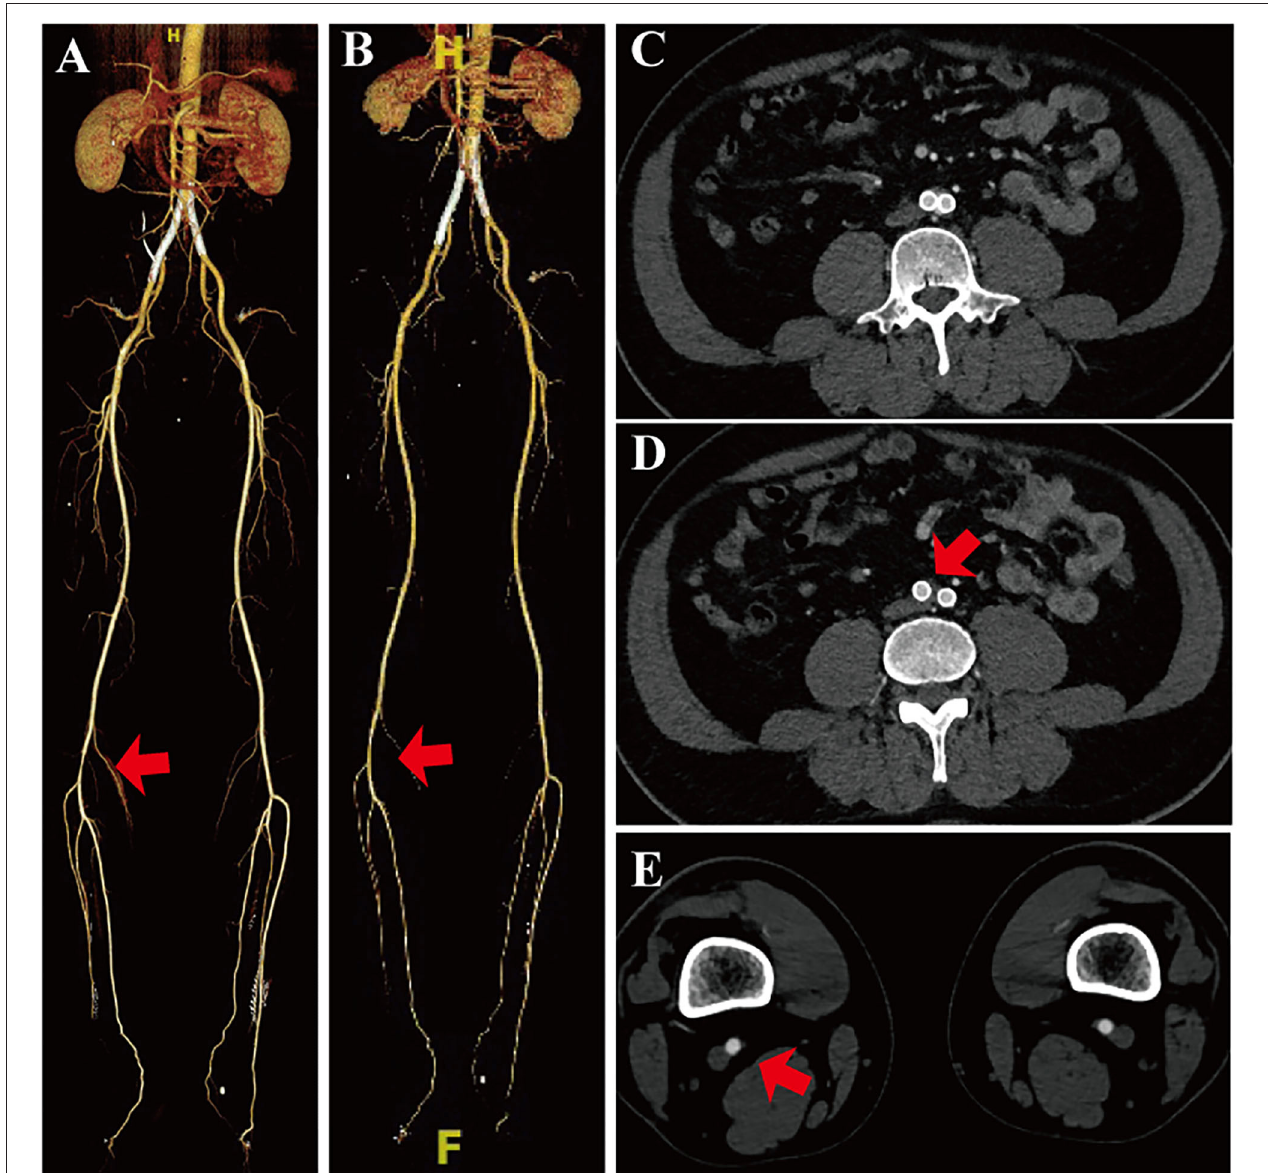
FIGURE 3 | Follow-up CTA of the same patient. (A) CTA shows the patency of the bilateral common iliac artery and the right popliteal artery after 6 months (red arrow). (B) CTA shows the patency of the bilateral common iliac arteries and the right popliteal artery after 18 months (red arrow). (C–E) Cross-section of CTA of 18